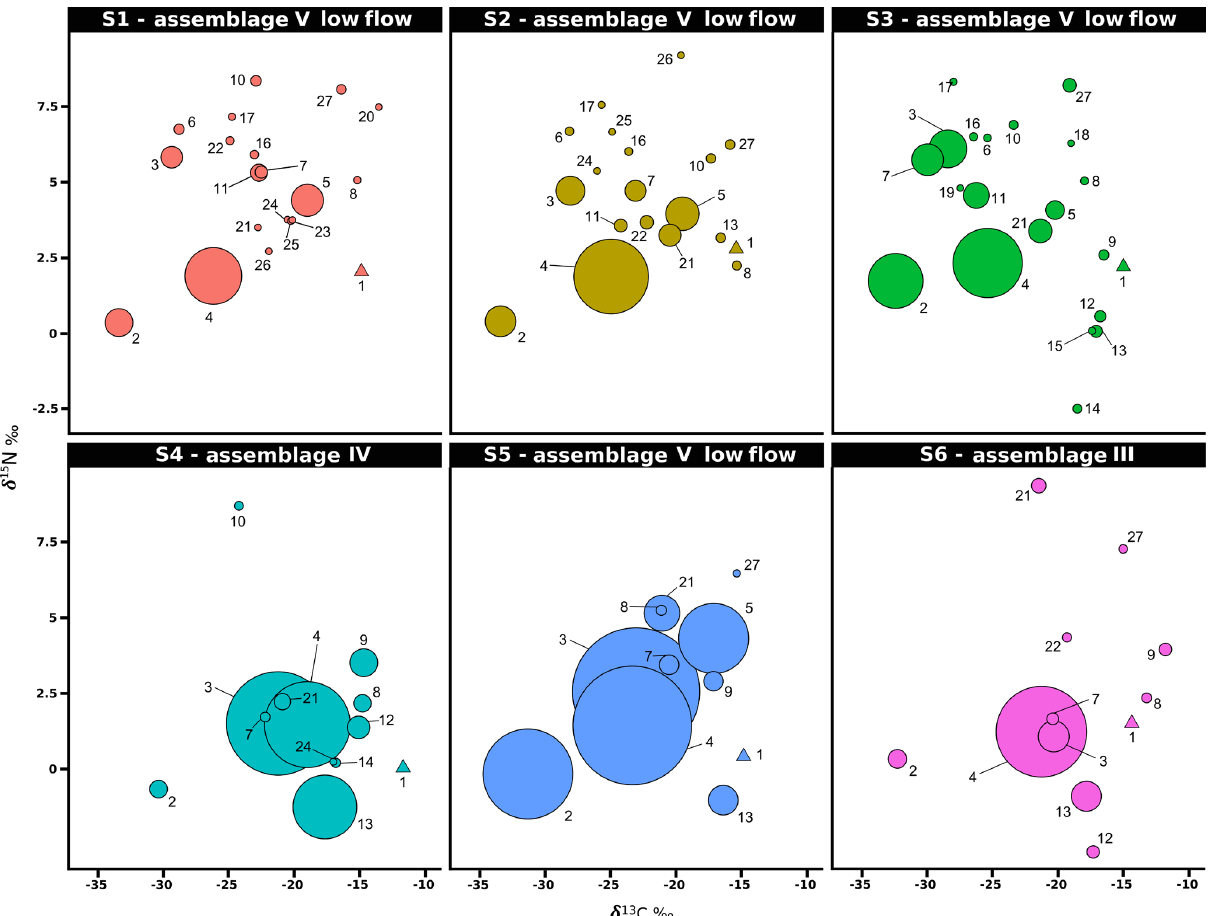
Figure 5. Stable isotope bi-plots showing vent consumers’ isotope signatures weighted by biomass per square metre of tubeworms (filled circles) for the six vent assemblages (S1 to S6) sampled on the Grotto hydrothermal edifice. Considered as a habitat, the biomass of Ridgeia piscesae (denoted by a triangle symbol) is not shown. Each vent species is designated by a number: 1 – Ridgeia piscesae ; 2 –